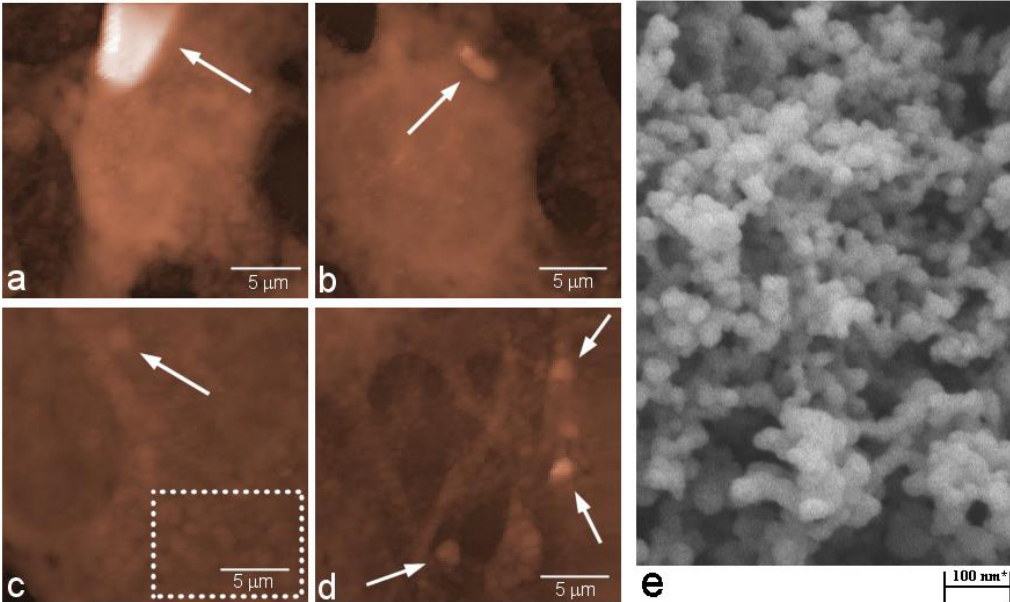
Figure 3. Magnified portions of Figure 1 ( a – d ) , along with an SEM image of HAp nanoparticles ( e ) , confirming that what is visible in Figure 1 are agglomerates of individual nanoparticles rather than nanoparticles per se. White arrows point at the key particles discussed in the text. The dashed rectangle in ( c ) denotes an area brimming with spherical entities, which are fine nanoparticle agglomerates resting on or inside the cell.